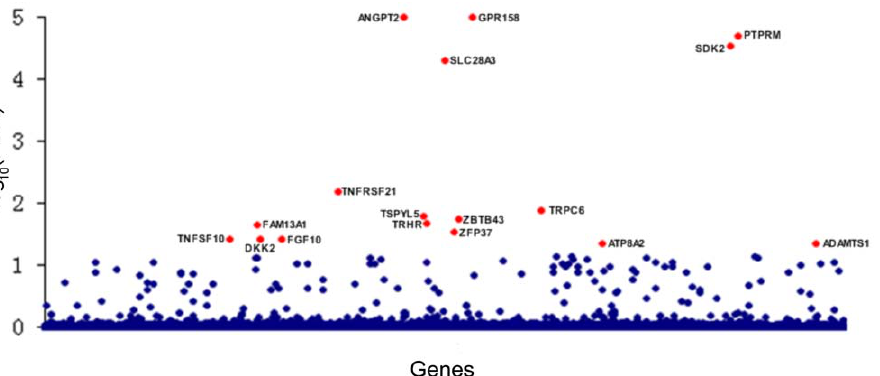
Figure 3. Plot of genome-wide MLAS results of lean body mass implemented by PLS-based MLAS. Significant genes are highlighted in red.